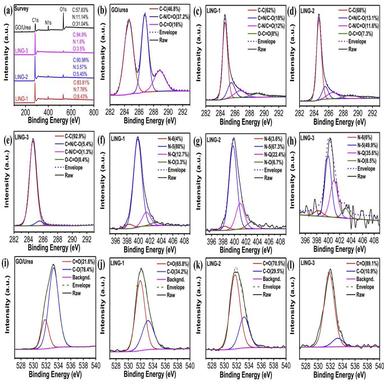
(a) XPS surveys of GO/urea mixture and different LING films. (bee) Typical high resolution XPS C 1s spectra of the GO/urea mixture and various LING films. (feh) Typical high resolution XPS N 1s spectra of the GO/urea mixture and different LING films. (iel) Typical high resolution XPS O 1s spectra of the GO/urea mixture and different LING films. The values in parentheses are the integrated area percentage of XPS C1s, N1s and O1s deconvoluted components. (A colour version of this figure can be viewed online.)